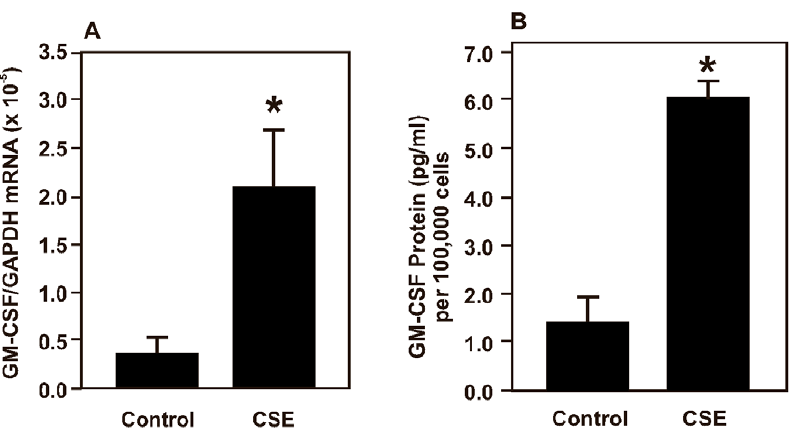
Figure 2. Cigarette smoke extract increases GM-CSF expression in B6Tert-1 cells. (A) Bar graph of real-time RT-qPCR data of GM-CSF mRNA expression in B6Tert-1 cells treated with 10% CSE in growth medium for 2 days. The relative GM-CSF mRNA expression level was determined against the glyceraldehyde-3-phosphate dehydrogenase (GAPDH) mRNA level. Data are mean 6 SEM. The asterisk (*) indicates a statistically significant difference ( p , 0.05), when compared with the control (untreated) cells. (B) Bar graph of GM-CSF ELISA data of the secreted GM-CSF in B6Tert-1 conditioned medium. The medium was collected after 2 days of exposure to 10% CSE. The asterisk (*) indicates a statistically significant difference ( p , 0.05), when compared with the control (untreated) cells. Data are mean 6 SEM.